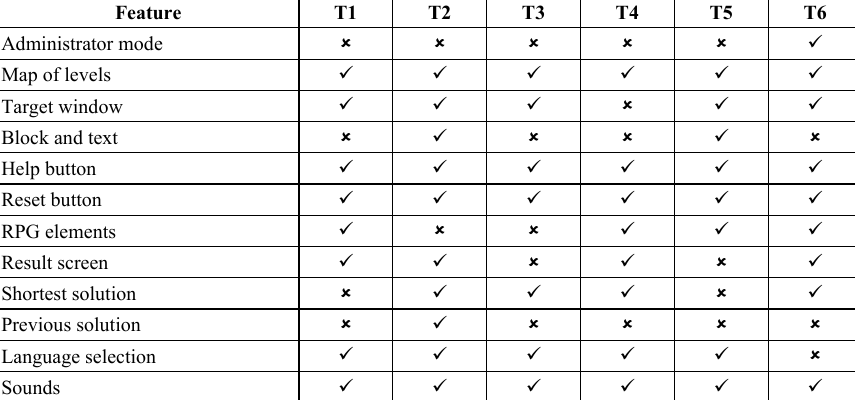
Table 1. Features of the analyzed tools and the one